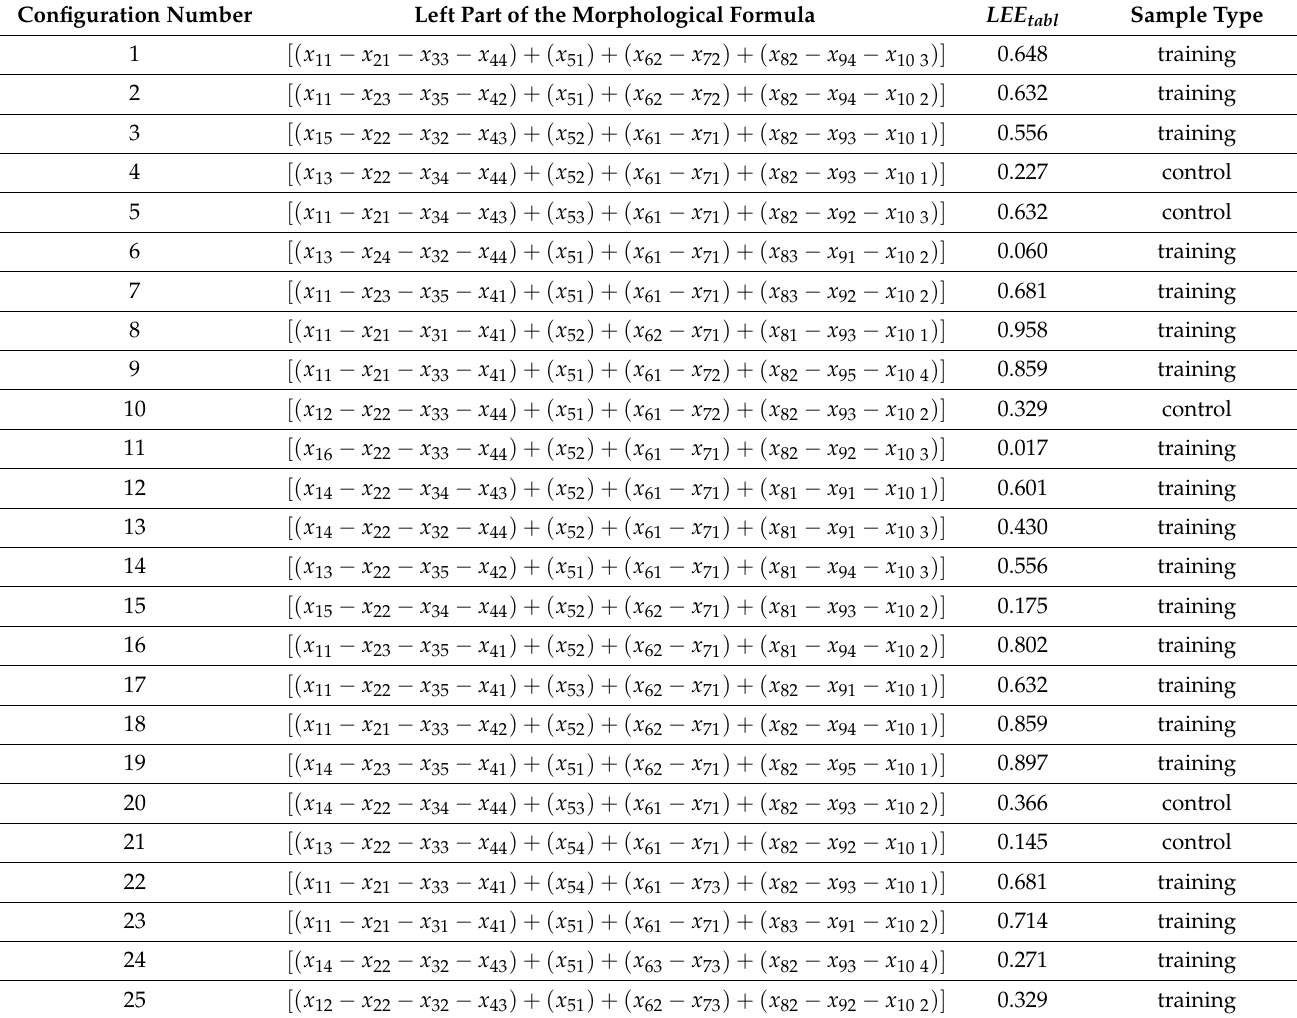
Table 4. Input data for building a fuzzy inference